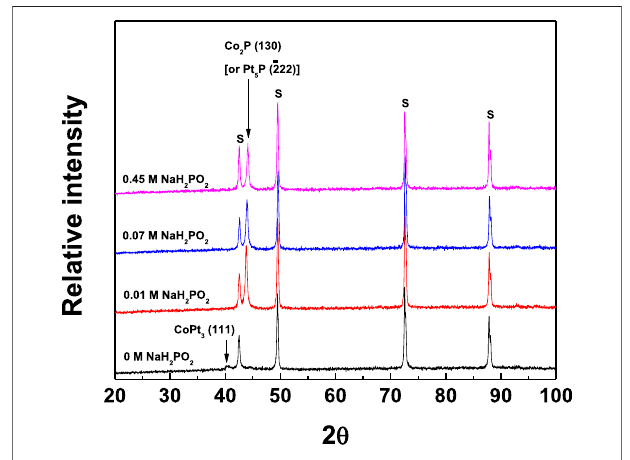
FIGURE 10 | XRD patterns of CoPt and CoPtP thin fi lms electrodeposited on brass substrate with the change of NaH 2 PO 2 concentrationintheplatingbaths;relativeintensityvsNaH 2 PO 2 concentration (S: substrate).